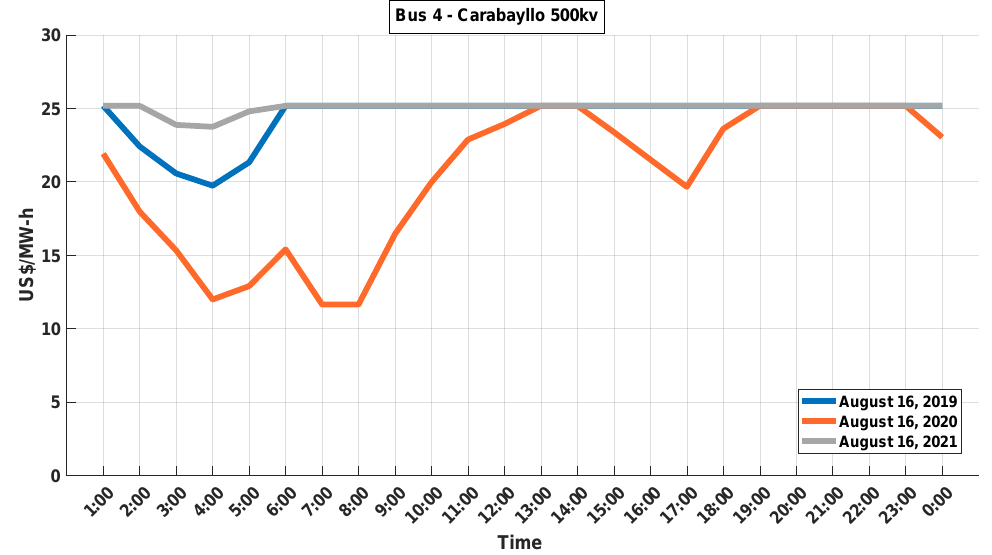
Figure 28. Variations of the bus prices by stage (bus